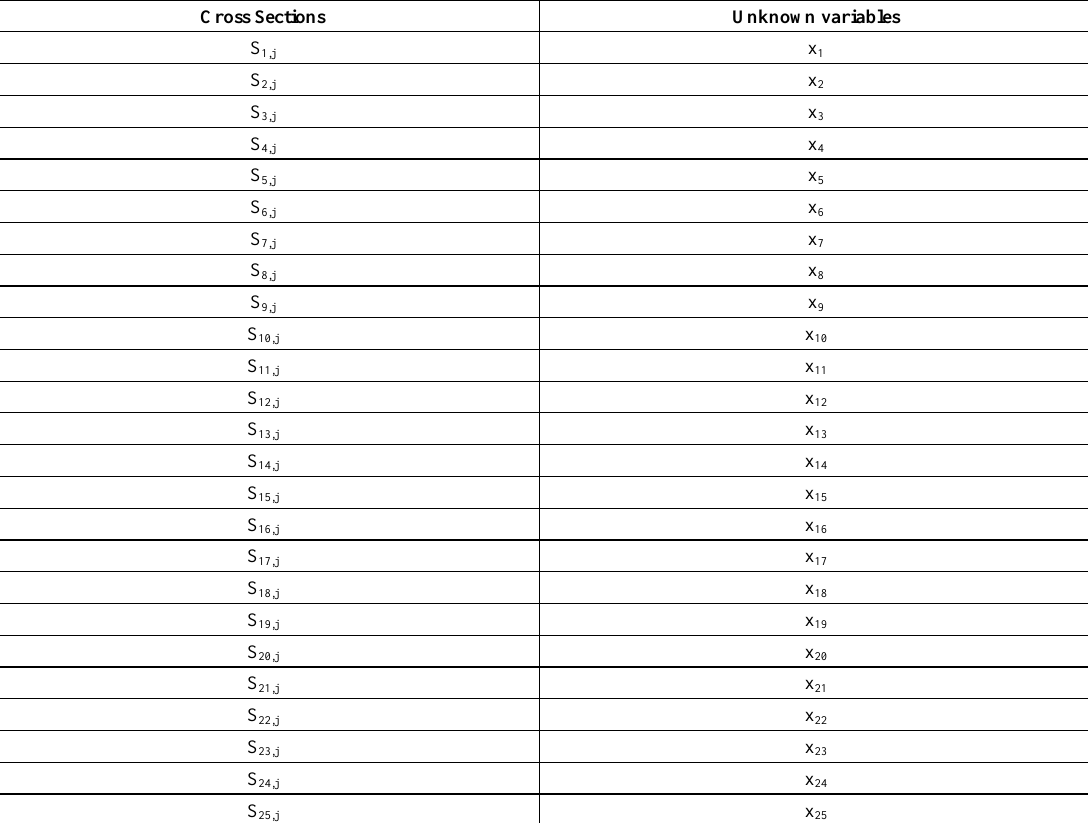
Table 5. Variables (𝑥 Cross